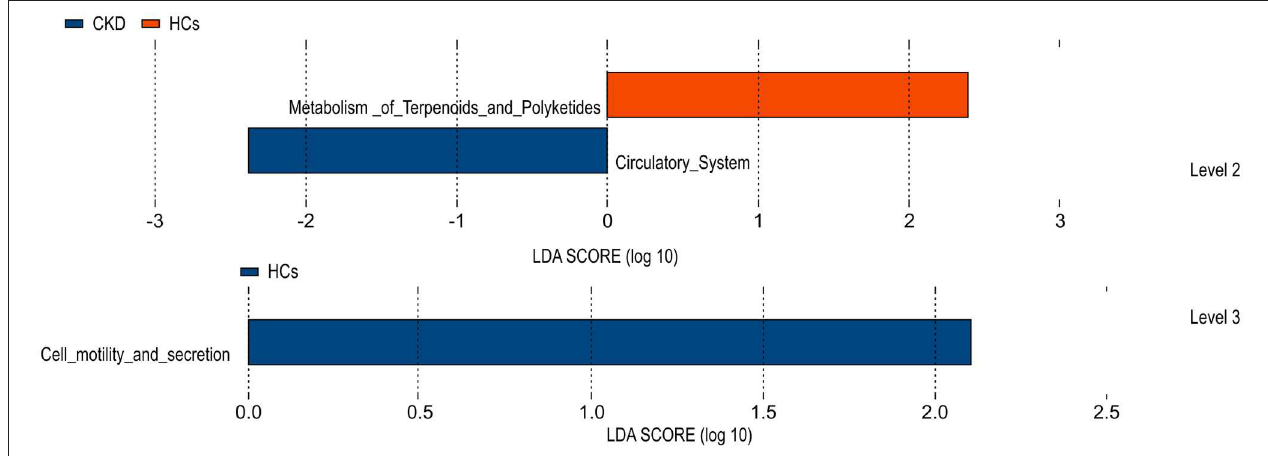
FIGURE 5 | Functional predictions for the fecal microbiome exhibited by the patients with chronic kidney disease (CKD) and the healthy control (HC)